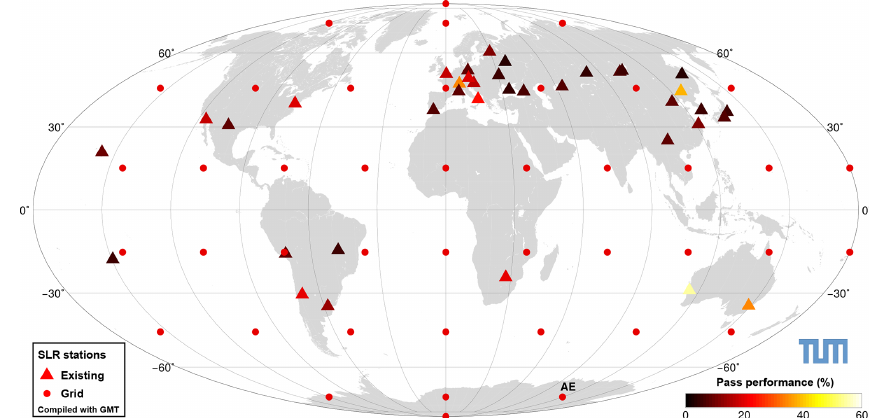
Figure 1. Global SLR network and locations of simulated SLR stations. Colours indicate the simulated performance; for existing stations, these were taken from Kehm et al. (2017), for each additional station, a performance of 20% has been assumed. For the explicit values please refer to Table 2. The station marked with “AE” (Antarctica East) is the station for which an additional scenario with lower performance has been simulated.